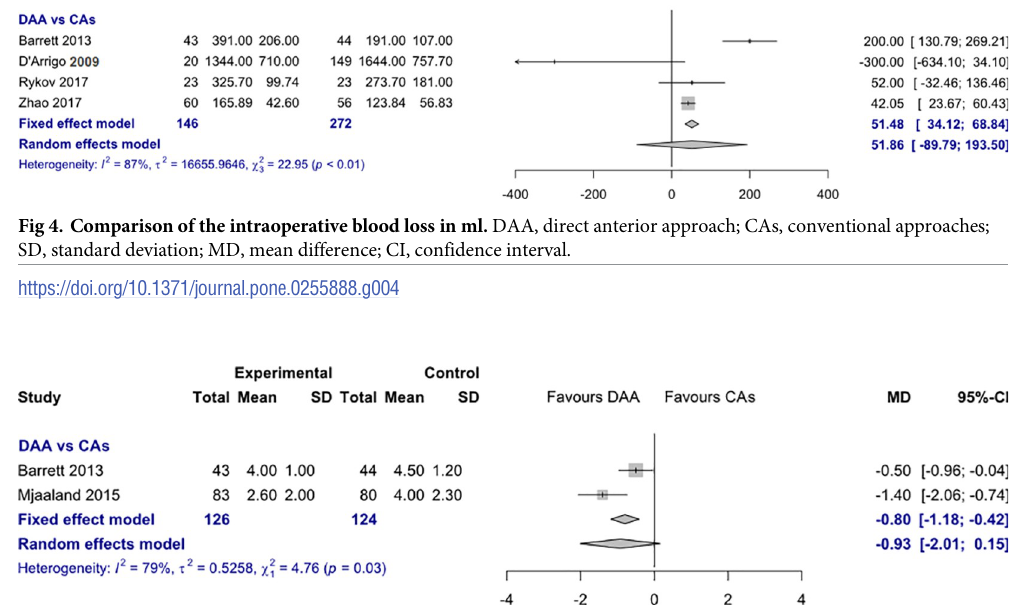
Fig 5. Comparison of the pain VAS 1 day postoperatively. DAA, direct anterior approach; CAs, conventional approaches; SD, standard deviation; MD, mean difference; CI, confidence interval.